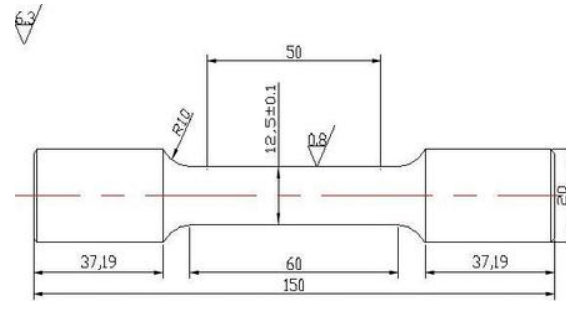
Figure 2. Dimensions of tensile specimen in mm.